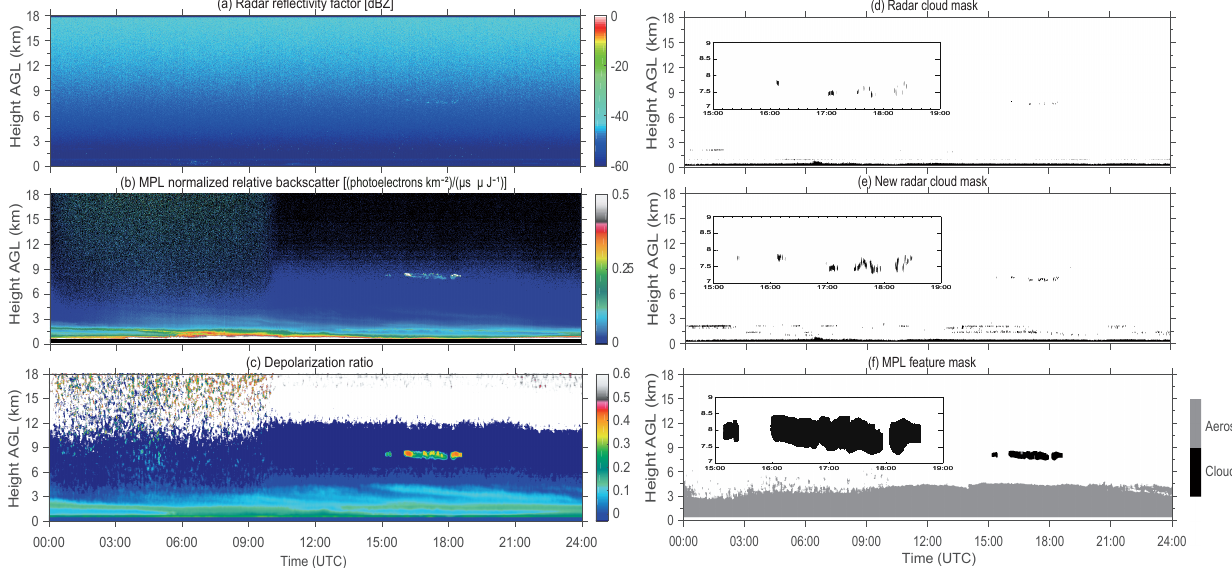
Figure 7. One-day example of radar- and lidar-observed cirrus clouds at the SACOL on 8 January 2014. (a) KAZR reflectivity; (b) MPL normalized backscatter intensity; (c) MPL depolarization ratio; (d) radar cloud mask derived by the ARM MMCR algorithm; (e) radar cloud mask derived by our new method; (f) MPL feature mask. Three windows in (d) , (e) and (f) show the zoom-in views of cirrus masks.